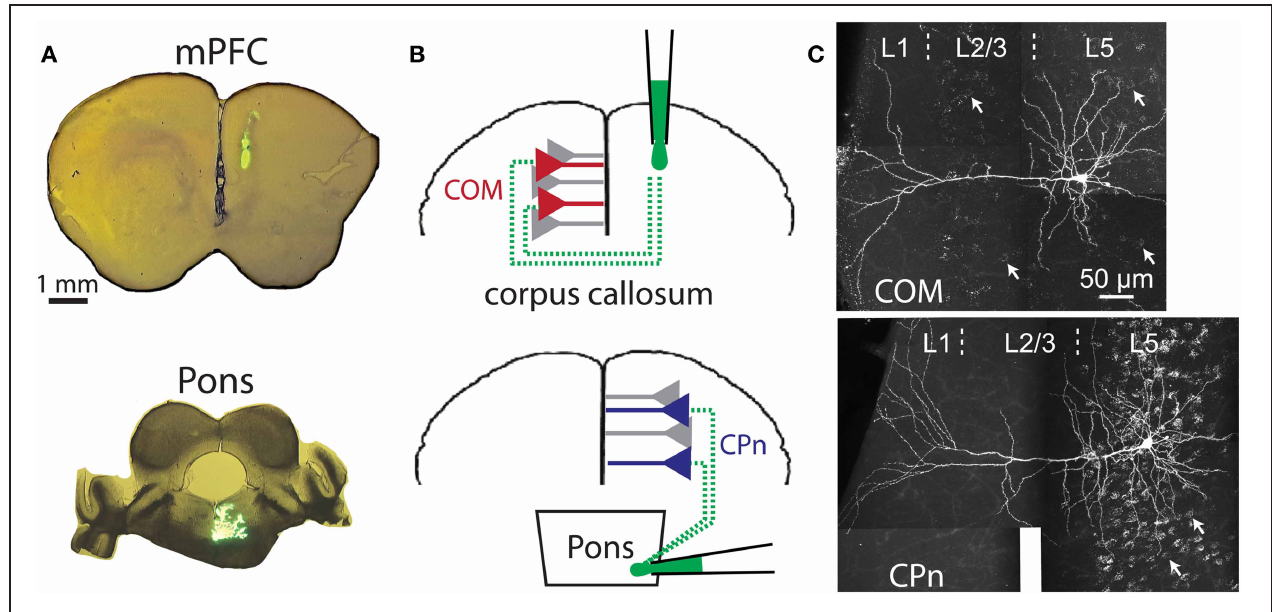
FIGURE 3 | Retrograde labeling of prefrontal projection neurons. (A) Images of coronal sections of prefrontal cortex (top) or brainstem (bottom) showing locations of dye injection for retrograde labeling of callosal/commisseral (COM) and corticopontine (CPn) projection neurons. (B) Cartoons of retrograde labeling of COM (top) and CPn neurons (bottom).